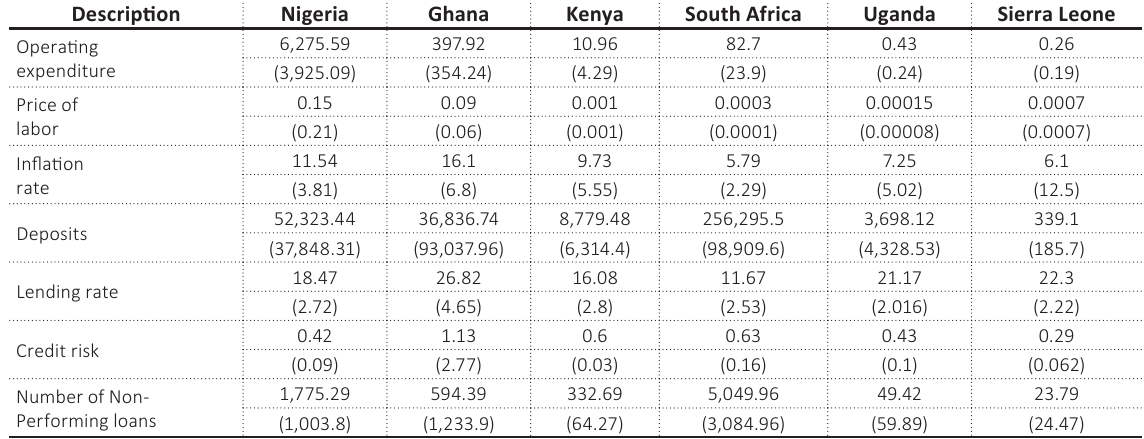
Table A2 (cont.). Summary statistics of variables employed for selected